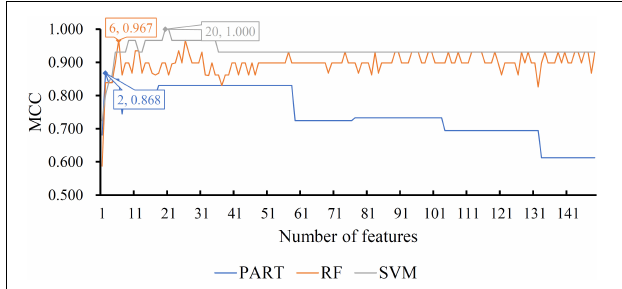
FIGURE 5 | IFS curves with different classification algorithms on different number of methylation features for DLPFC brain structure. The RF, SVM, and PART yield the highest MCC of 0.967, 1.000, and 0.868, respectively. They are obtained by using top 6, 20, and 2, respectively, features in the list.